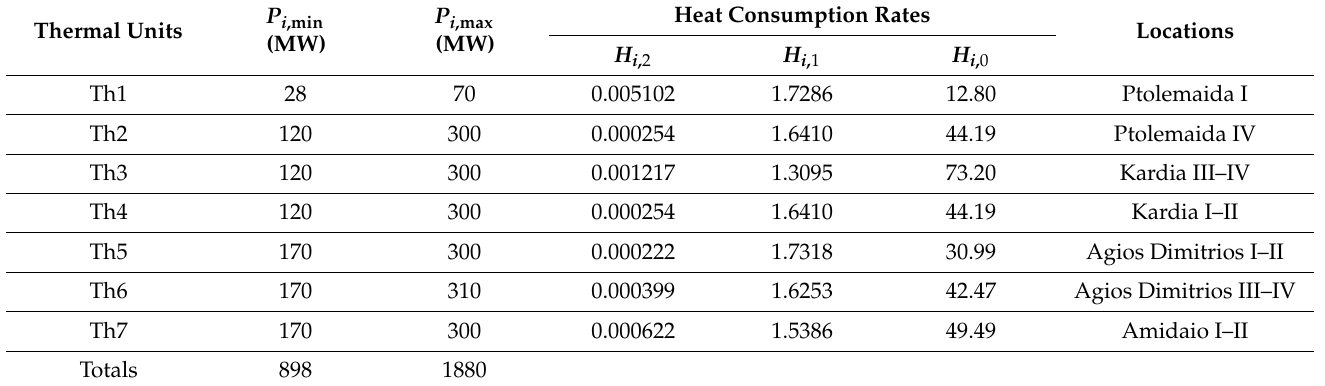
Table A1. Ratings of Seven Thermal Units in North-West of Greece.